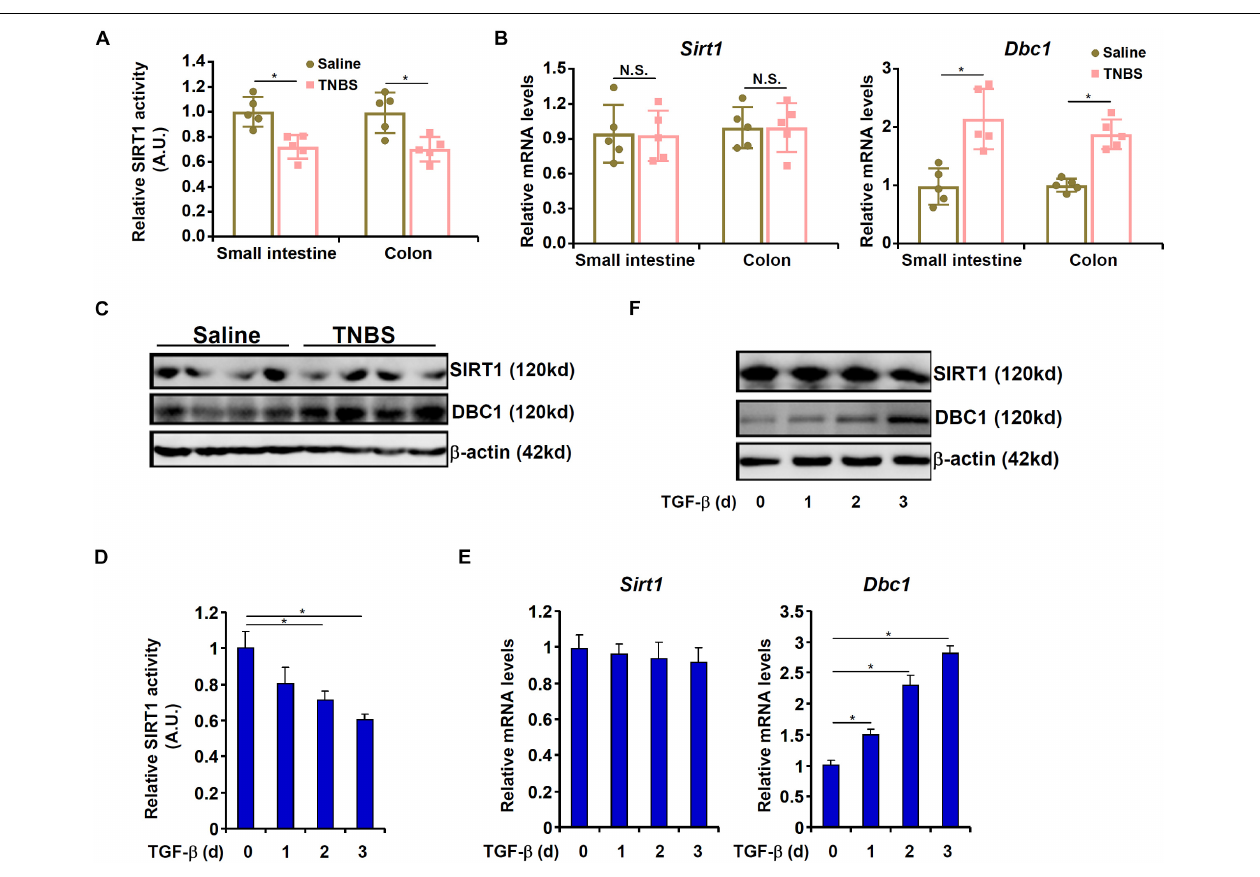
FIGURE 2 | SIRT1 activity is down-regulated by TNBS in vivo and by TGF- β in epithelial cells in vitro . (A–C) Colitis was induced in C57B/6 mice by TNBS as described in section “Materials and Methods.” SIRT1 activity was determined by a colorimetric kit. Expression levels of SIRT1 and DBC1 were examined by qPCR and Western. N = 5 mice for each group. (D–F) IEC-6 cells were treated with TGF- β (2 ng/ml) and harvested at indicated time points. SIRT1 activity was determined by a colorimetric kit. Expression levels of SIRT1 and DBC1 were examined by qPCR and Western. All experiments were performed in triplicate wells and repeated three times. One representative experiment is